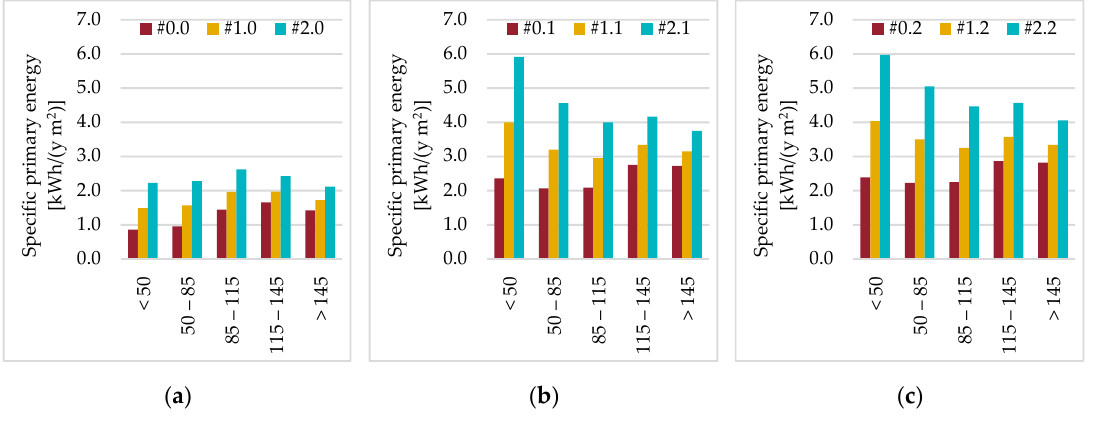
( c ) Figure 15. Florence: Specific primary energy consumption for cooling. ( a ) Existing equipment; ( b ) existing equipment + 1 air conditioner; ( c ) existing equipment + 2 air conditioners. ( a ) ( b ) ( c ) Figure 16. Rome: Specific primary energy consumption for cooling. ( a ) Existing equipment; ( b ) existing equipment + 1 air conditioner; ( c ) existing equipment + 2 air conditioners.